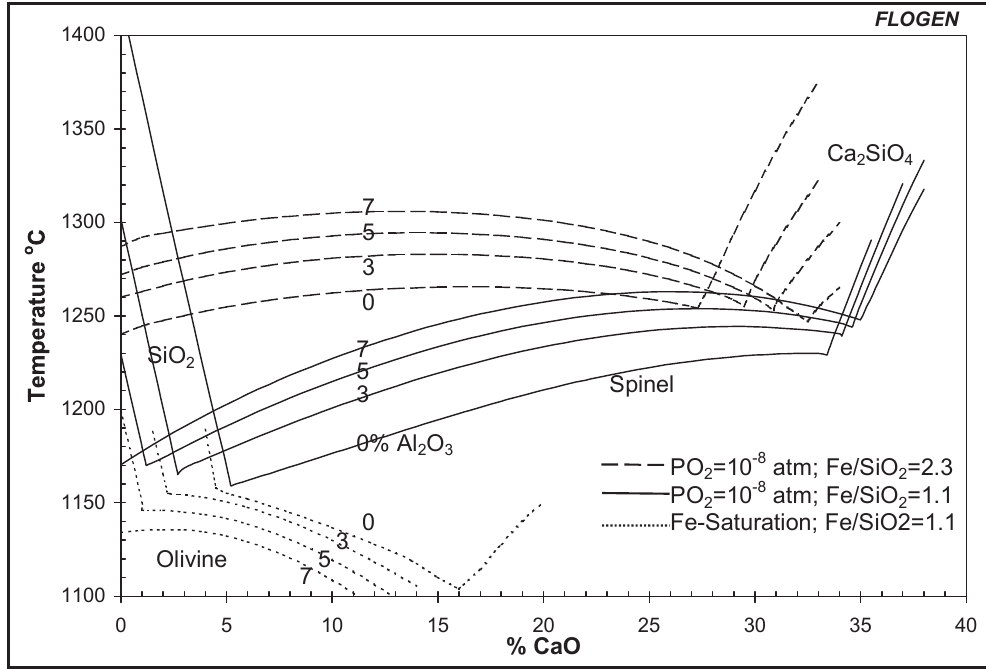
D 10 (cid:3) 8 atm and several Fe = SiO 2 ratios. 2